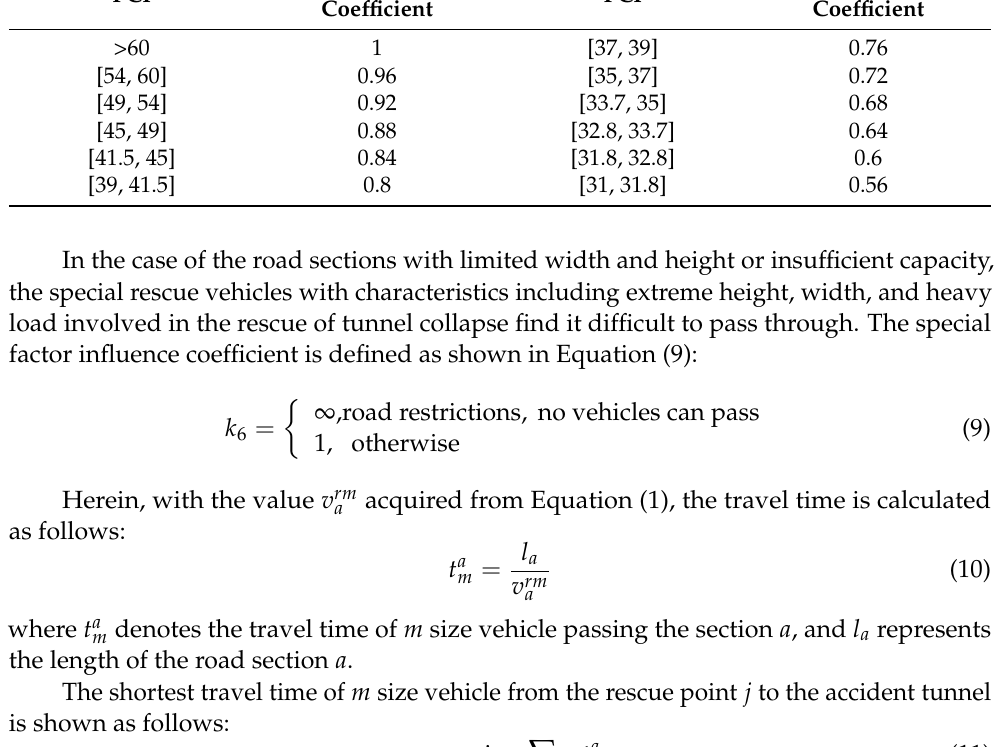
Table 4. Correction coefficients of 120 km/h highway in different pavement conditions. PCI